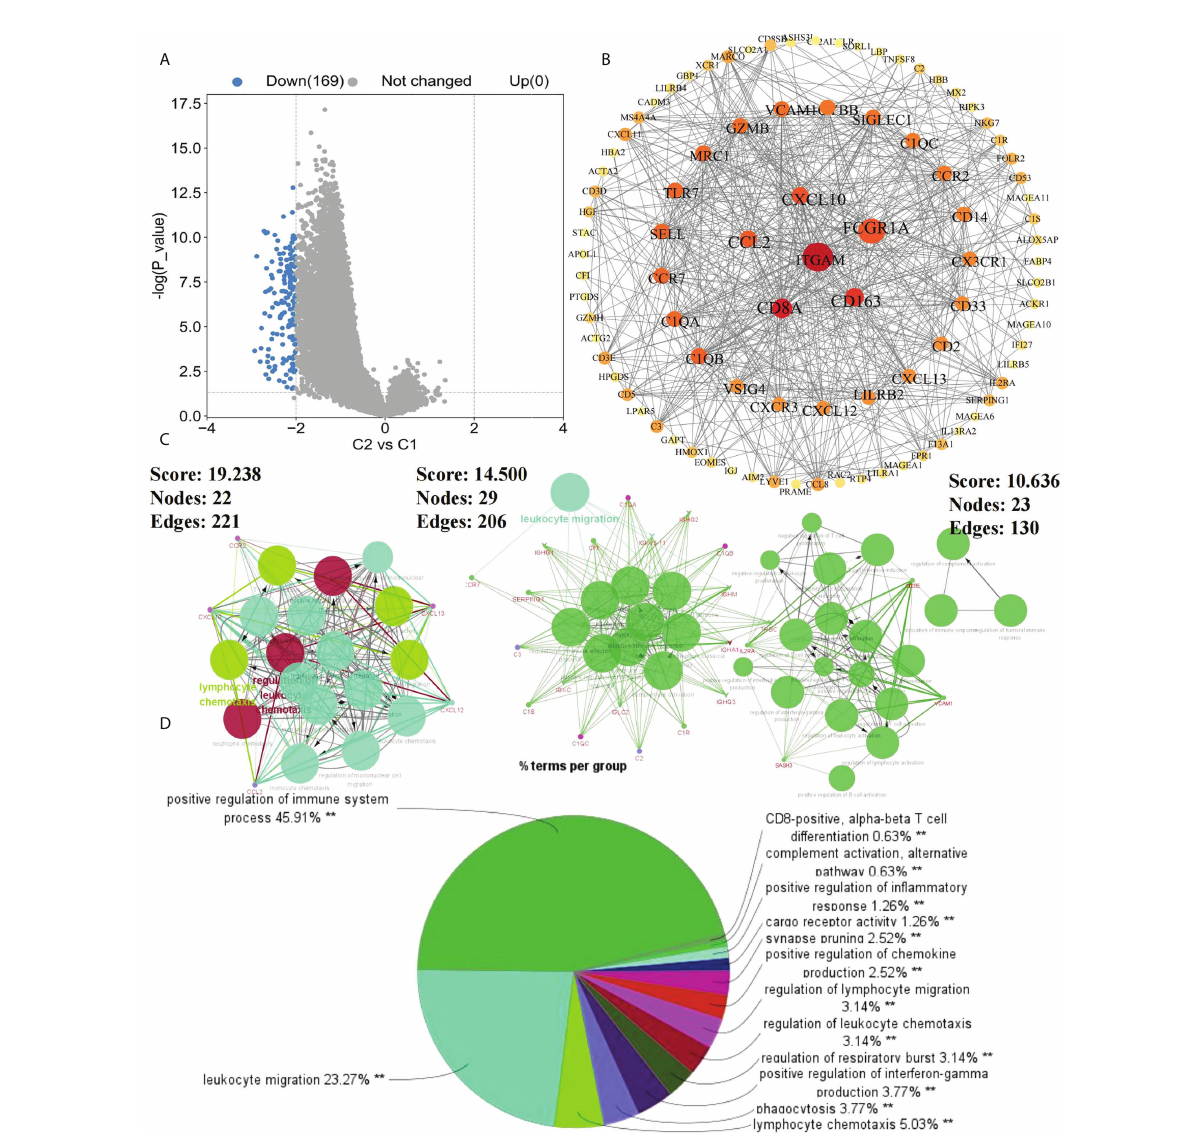
FIGURE 2 Enrichment results of DEGs. (A) DEGs between C1 and C2 subtypes (p<0.05, |logFC>2|); (B) Protein-Protein interaction (PPI) network of 169 DEGs between C1 and C2 subtypes; (C) Key modules in PPI selected according to MCODE; (D) ClueGo enrichment results of DEGs (**p <